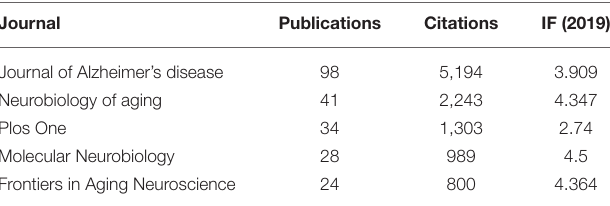
TABLE 3 | Number of publications from the top five journals.